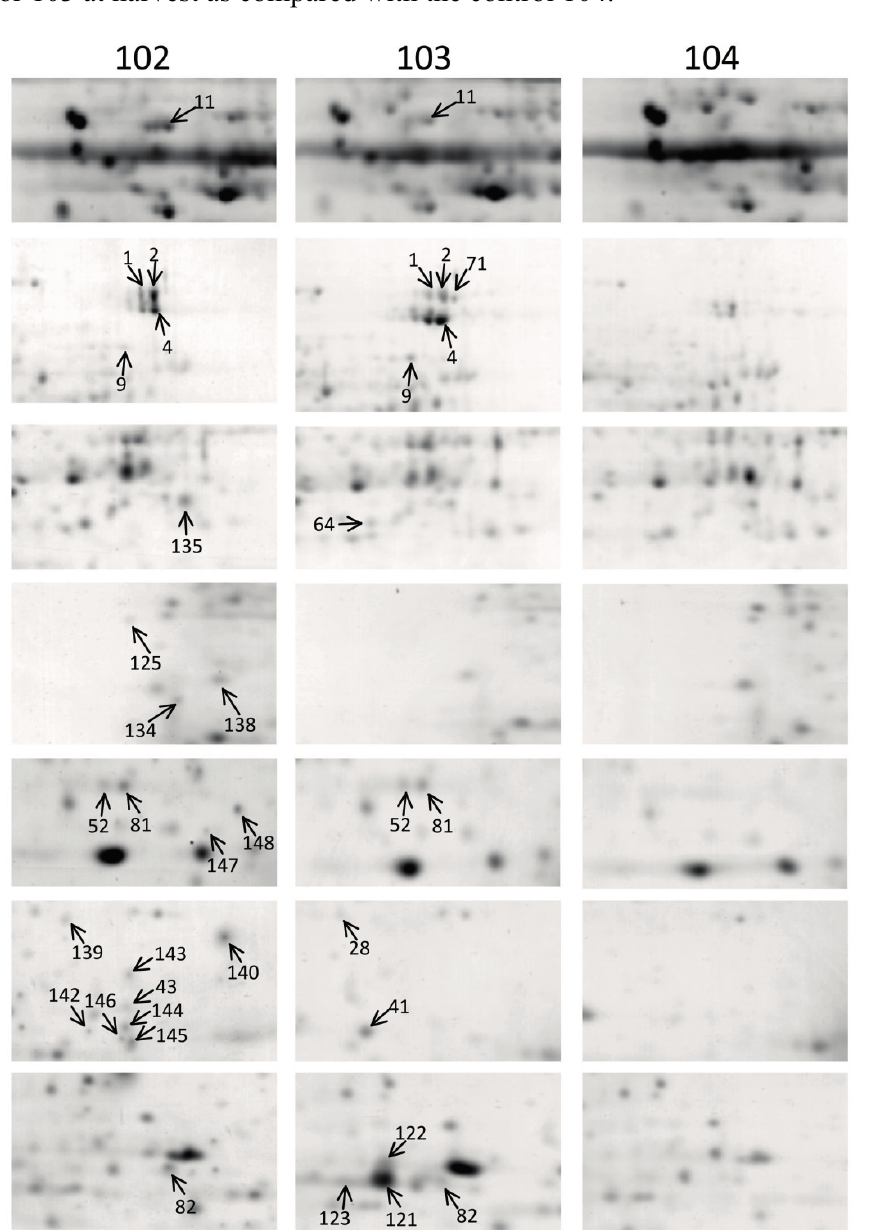
Figure 1. Protein spots specifically detected in isopentenyltransferase (ipt) -transgenic broccoli at harvest. Number indicates protein spots specifically detected in the 2 ipt -transgenic lines 102 or 103 at harvest as compared with the control